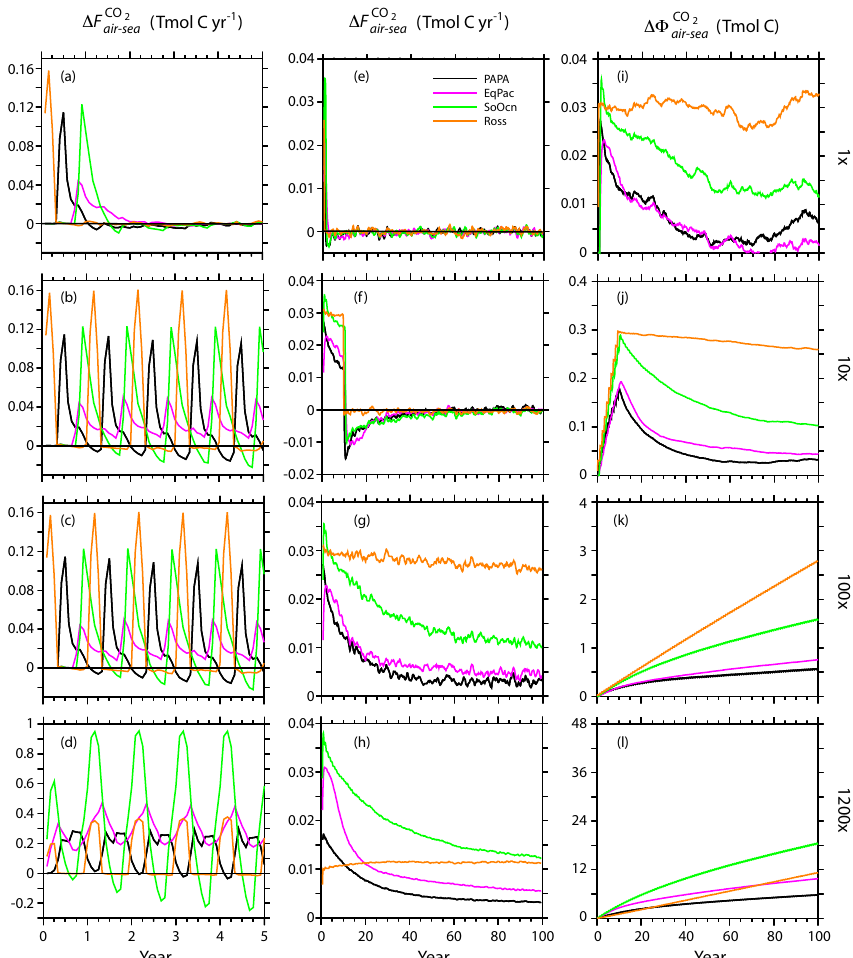
Fig. 8. Results of the iron fertilization scenarios plotted as a function of time for: (a–d) , annual uptake of CO 2 plotted month by month for the first 5 years, 1F CO 2 ; (e–h) , annual uptake of CO 2 from the atmosphere for 100 years, 1F CO 2 air − sea the atmosphere, 18 CO 2 . The first row of results is for the 1x scenarios, the second for the 10x scenarios, the third for the 100x scenarios, air − sea and the bottom row is for the 1200x